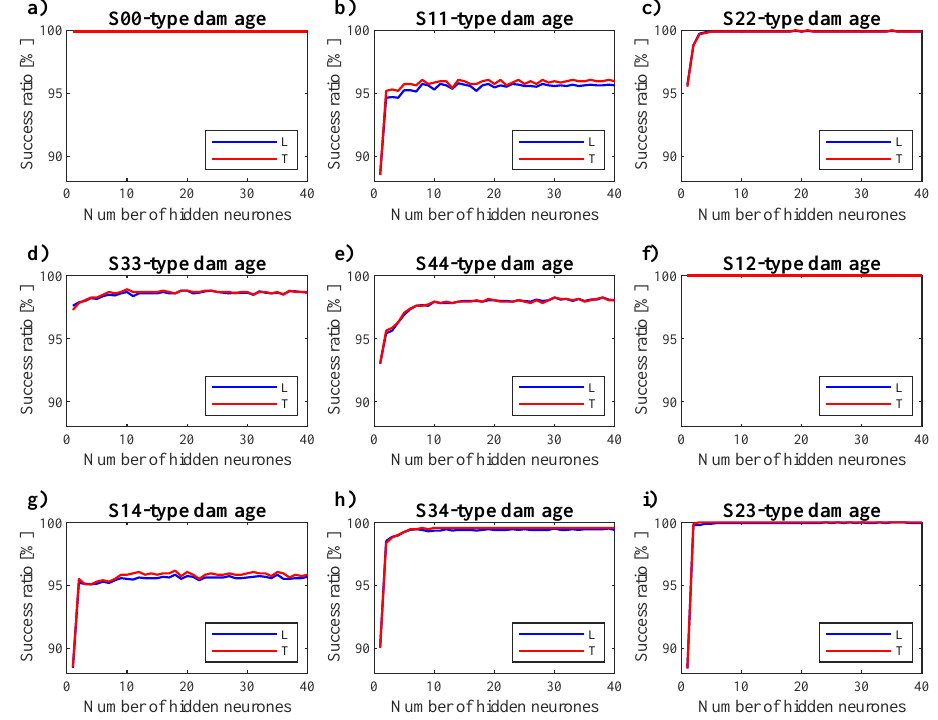
Figure 8. Optimization of ANN architecture (6-H-1 ANNs; inputs: differences between displacements of three vertices of the triangle in two selected states), damage type: ( a ) S00, ( b ) S11, ( c ) S22, ( d ) S33, ( e ) S44, ( f ) S12, ( g ) S14, ( h ) S34, ( i )